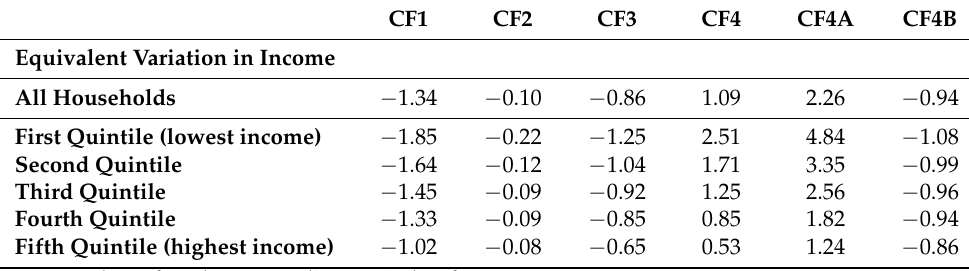
Table 8. Long run [2030] effects: welfare